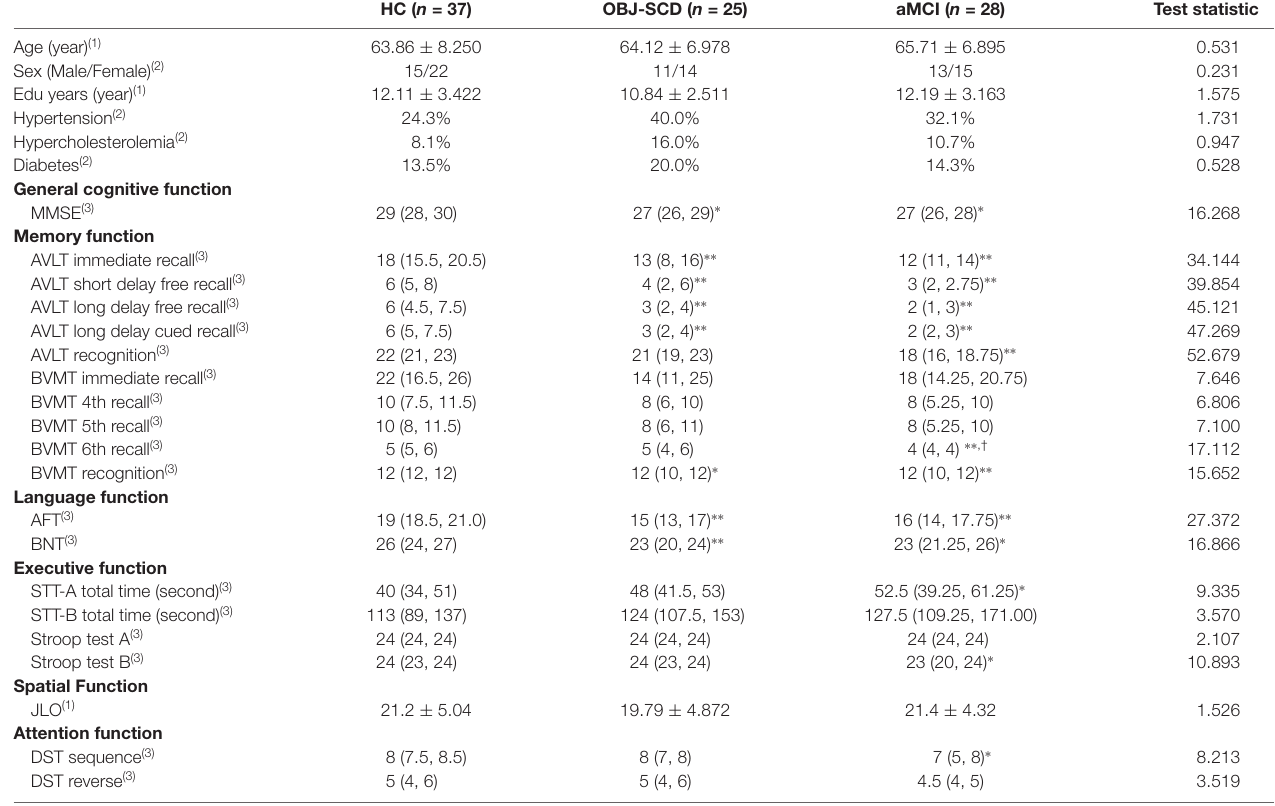
TABLE 1 | Demographic data and neuropsychological tests between